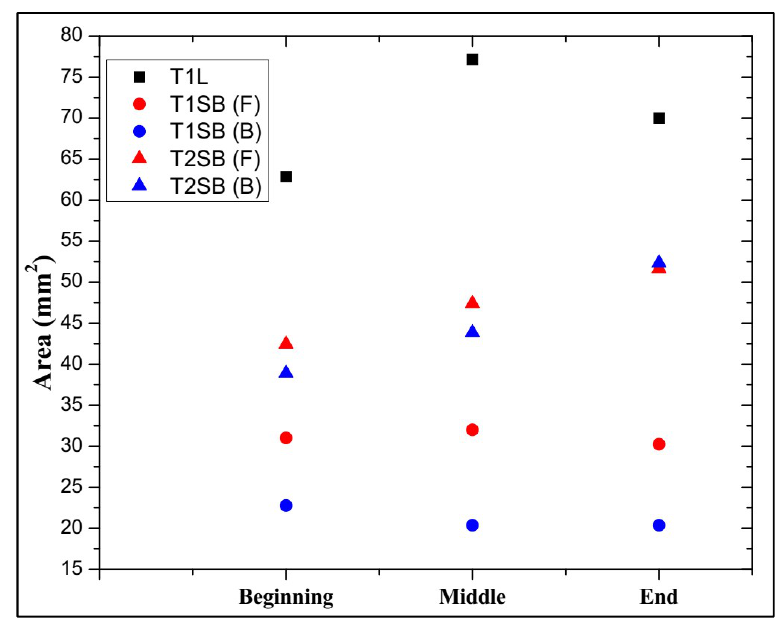
Figure 12. Areas of the hottest points at the plate backside, defined by the red isotherms, at different torch positions (progressively advancing): T1L (linear); T1SB (switchback with F = 30 mm and B = 20 mm); T2SB (switchback with F = 10 mm and B = 5 mm).